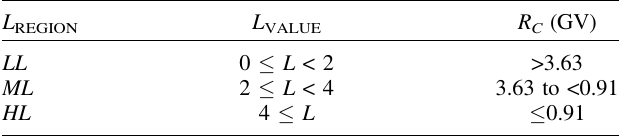
Table 3. L -value cuts and respective R C